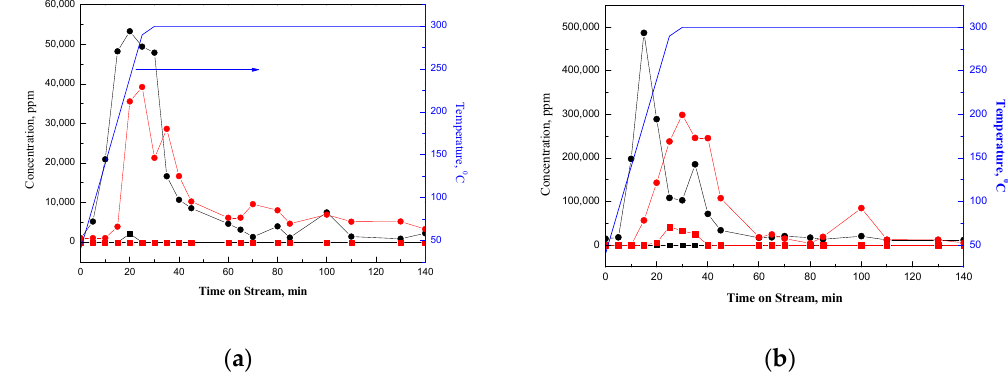
Figure 3. ( a ) CO 2 , CO formed in temperature programmed regeneration of EtOH-laden NaY-SiO 2 : CO 2 formed at high flow rate (black • ), CO 2 formed at low flow rate (red • ), CO formed at high flow rate (black ■ ), CO formed at low flow rate (red ■ ); blue line solid line in the figure is the setting temperature. ( b ) CO 2 , CO formed in temperature programmed regeneration of EtOH-laden Pt/NaY-SiO 2 : CO 2 formed at high flow rate (black • ), CO 2 formed at low flow rate (red • ), CO formed at high flow rate (black ■ ), CO formed at low flow rate (red ■ ).